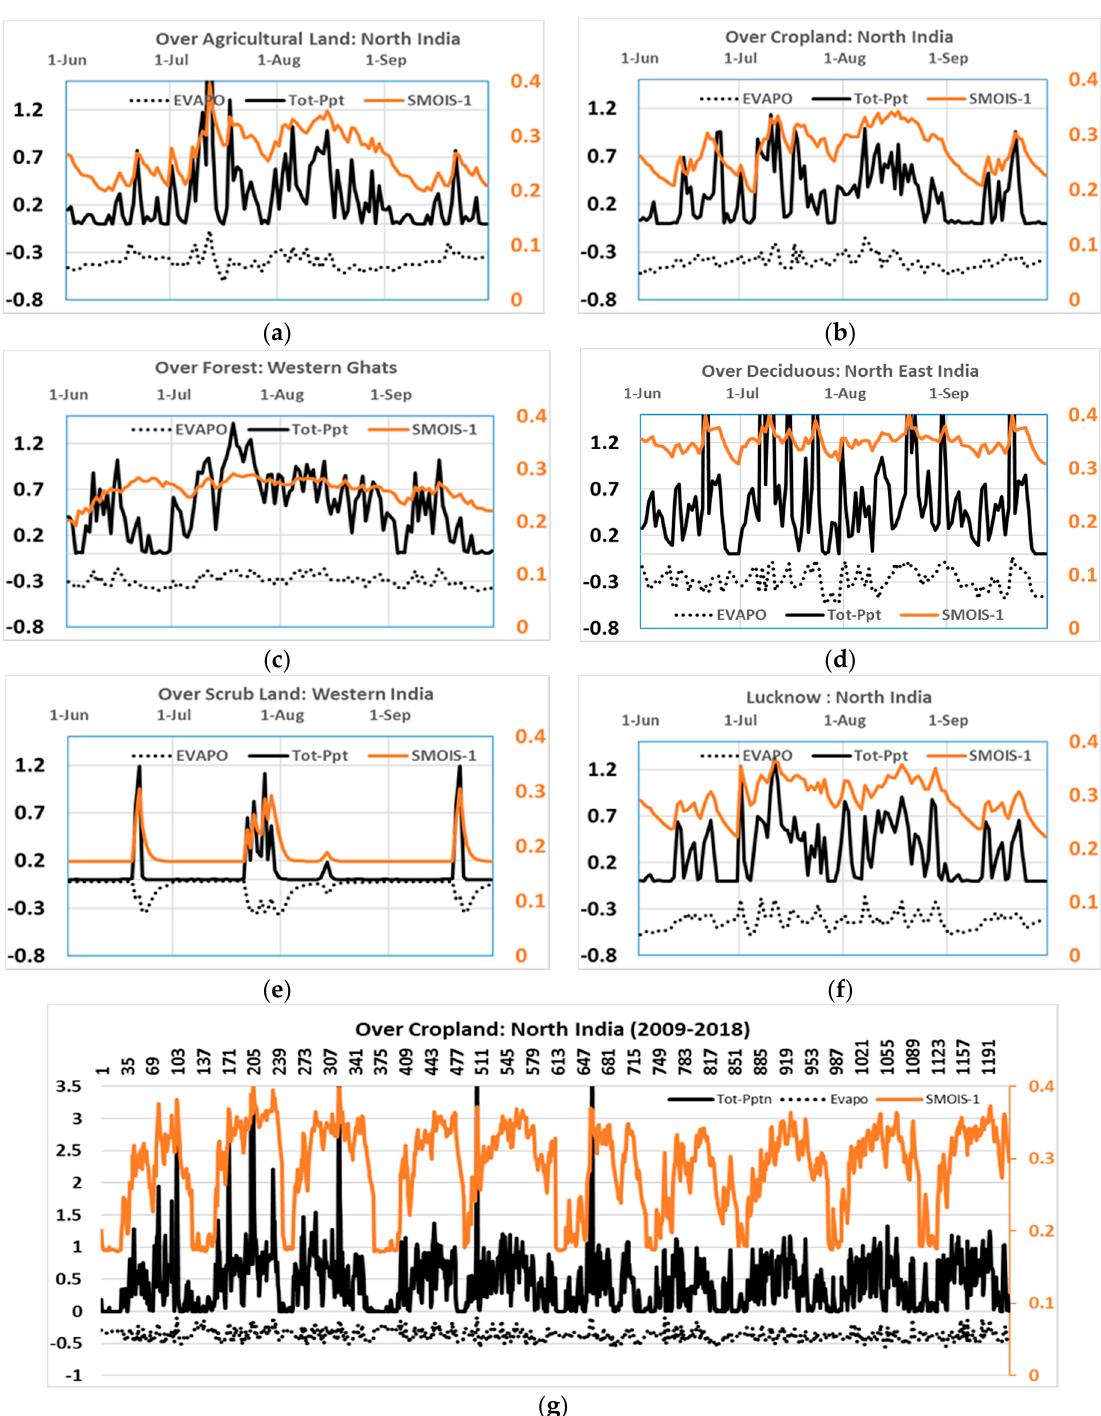
Figure 11. Variations of hydrological parameters such as evaporation (Evapo), total precipitation (Tot-Pptn), and soil moisture layer 1 (upper 7cm, SMOIS-1) for summer 2015 over selected regions of uniform land cover and land use (a) agricultural land, (b) crop land (c) forest, (d) deciduous, (e) urban area, (f) scrub land, and (g) crop land for ten years (2008-2019).